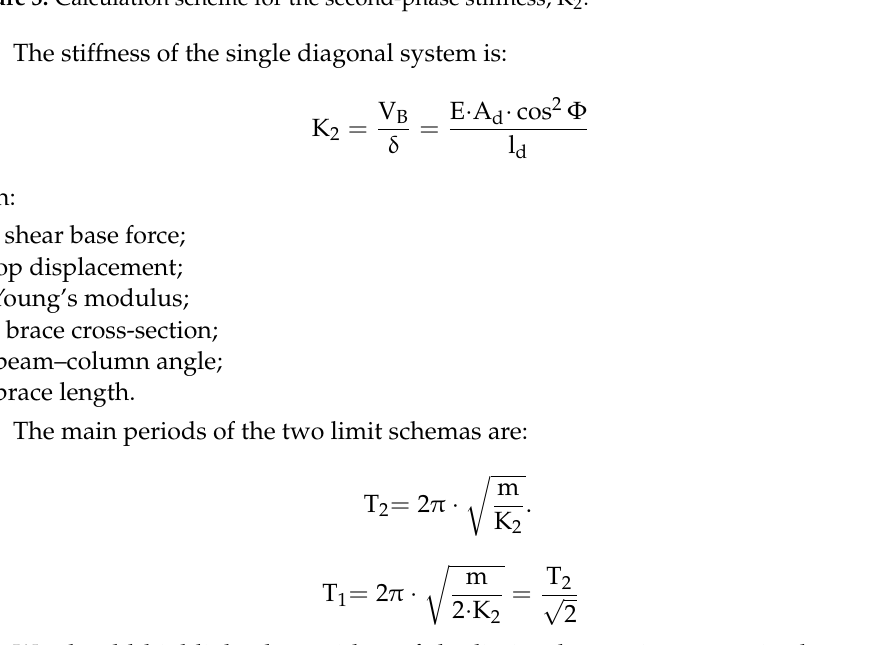
Figure 3. Calculation scheme for the second-phase stiffness, K 2